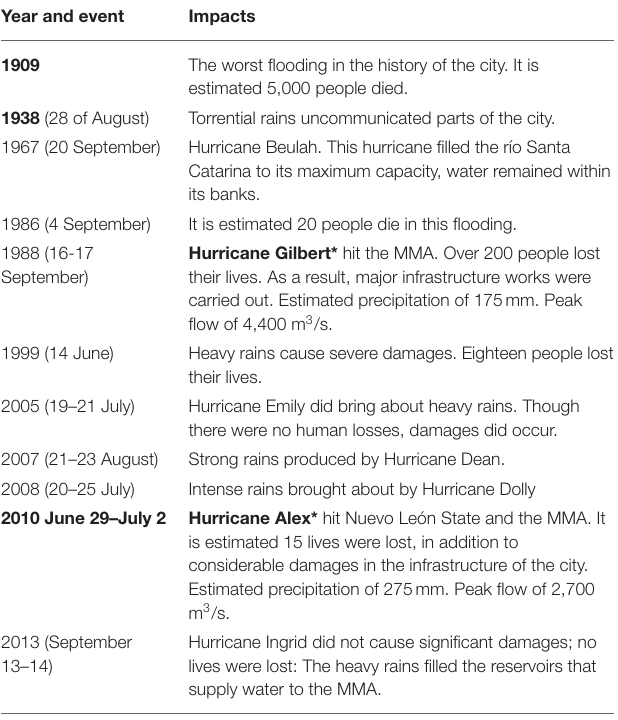
TABLE 1 | Flooding history of the Monterrey Metropolitan Area,